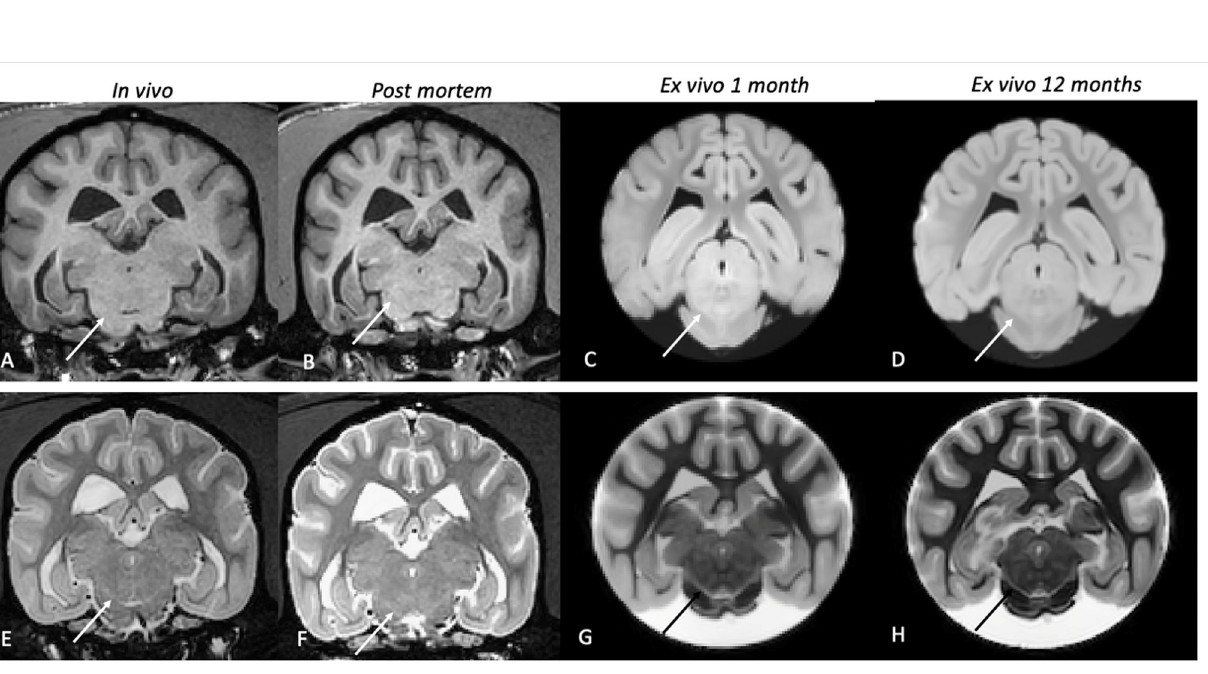
PLOS ONE | https://doi.org/10.1371/journal.pone.0261484 October 7,